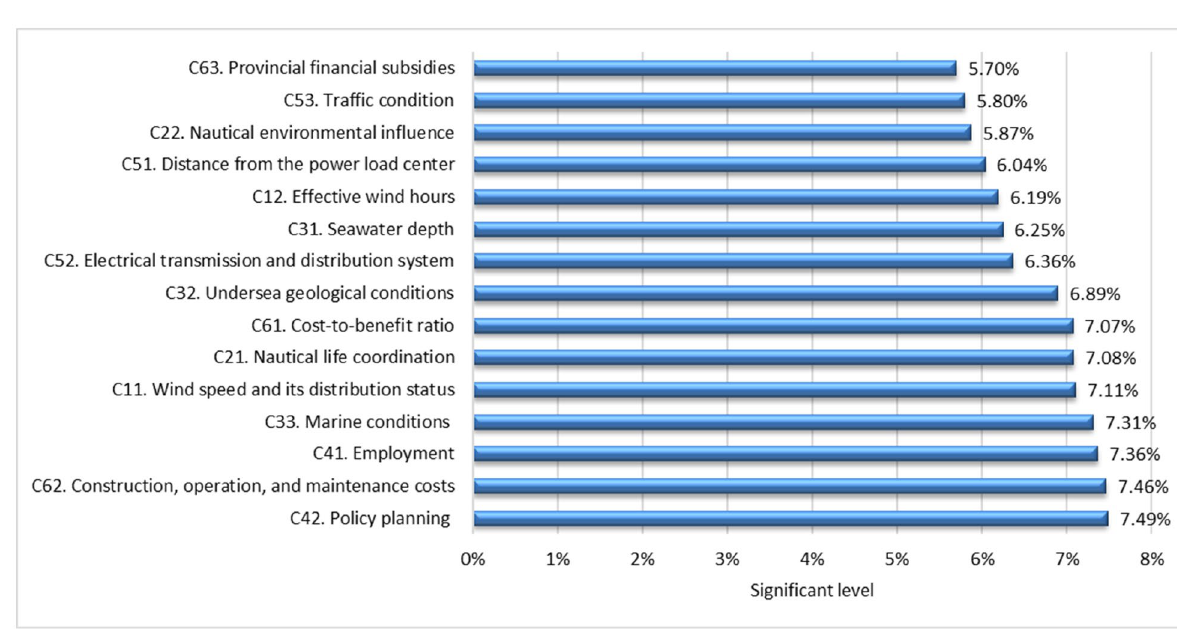
Figure 4. The influence level of criteria of the SF-AHP